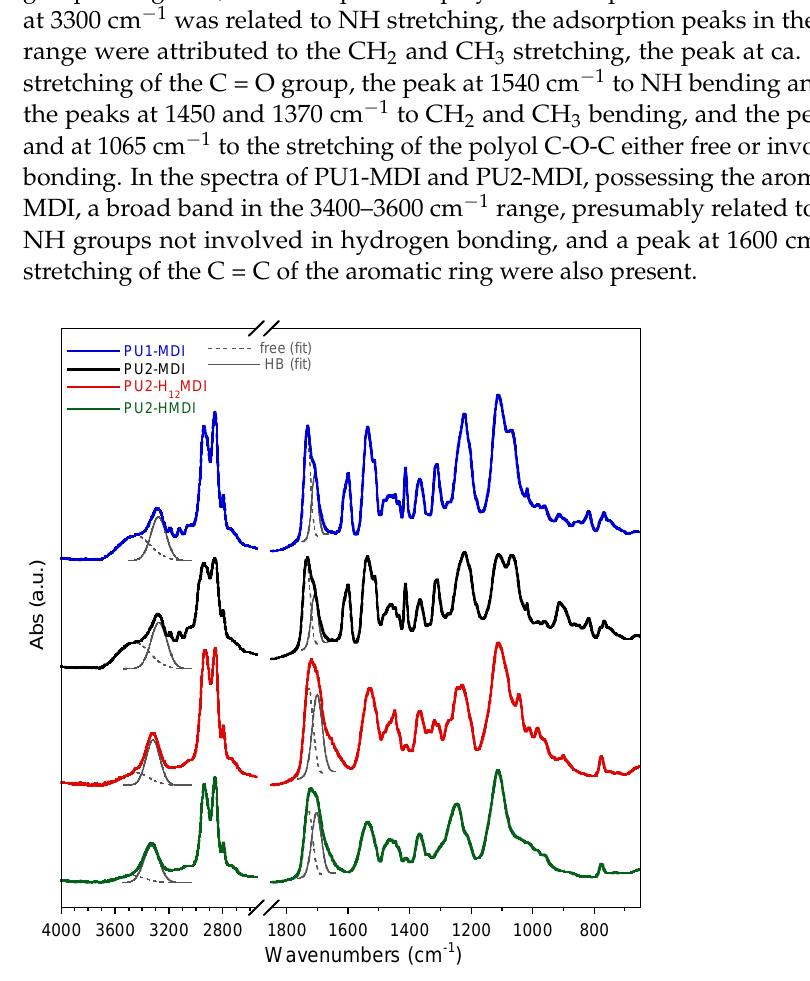
Figure 2. FTIR spectra of polyurethane ionomers. Band deconvolutions of the N-H stretching (3600–3200 cm − 1 ) with two Gaussians centered at about 3460 cm − 1 and 3300 cm − 1 for free ( ν N-H free ) and hydrogen-bonded N-H ( ν N-H HB ) and of the C = O stretching (1800–1600 cm − 1 ) with two Gaussians centered at about at 1730 cm − 1 and at 1705 cm − 1 for free ( ν C = O free ) and hydrogen- bonded C = O ( ν C=O HB